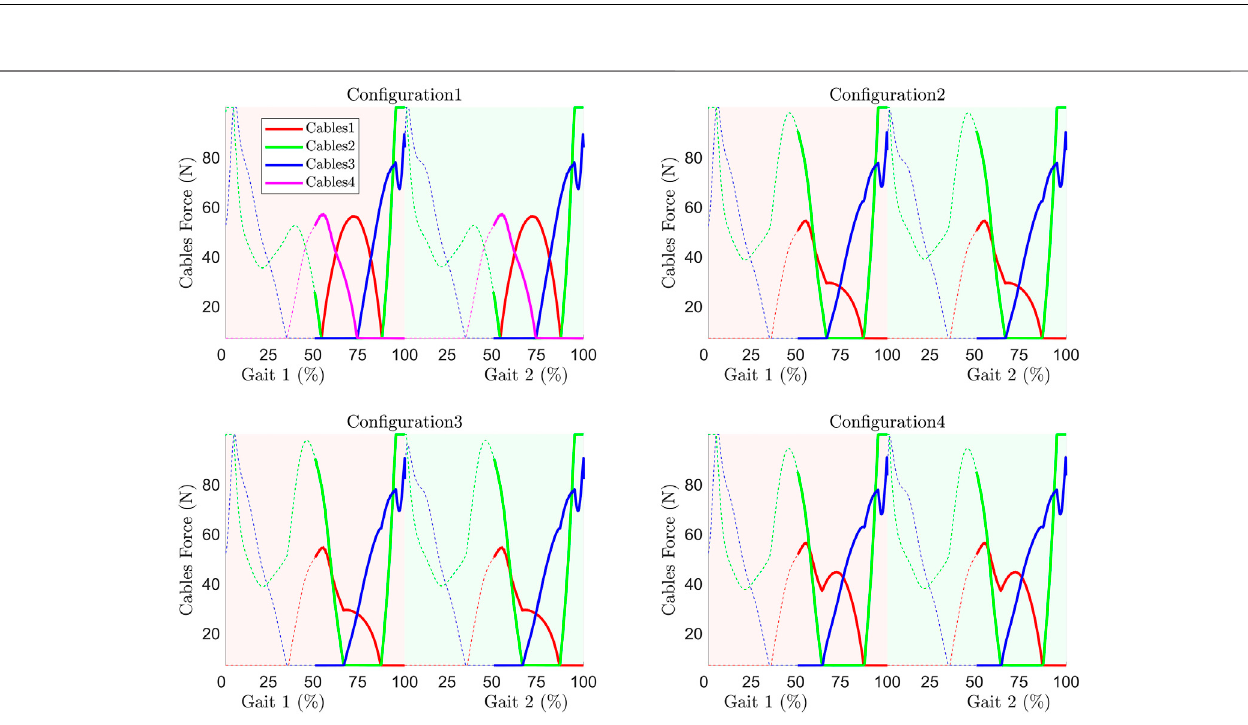
FIGURE 8 | Cable tension requirement during trajectory